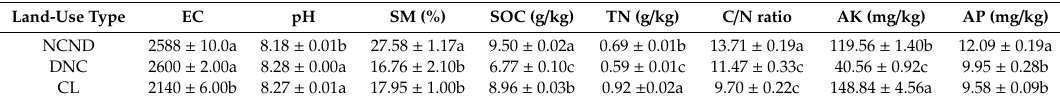
Table 1. Chemical properties of rhizosphere soil in three contrasting land use types along the drawdown zone of the Three Gorges